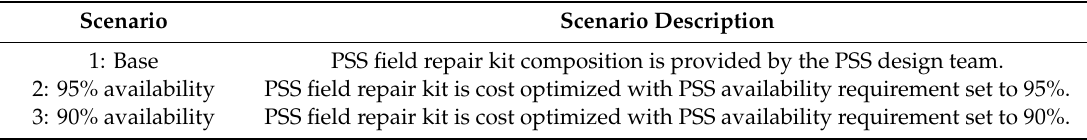
Table 4. Key parameters and their value ranges for simulation and optimization.